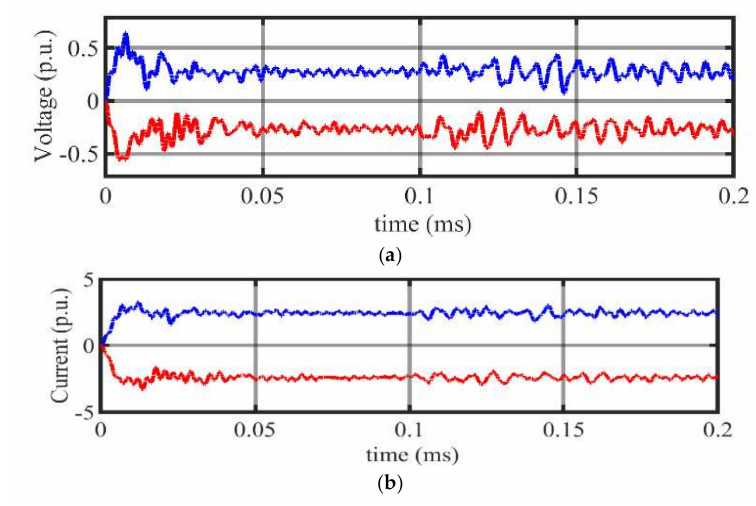
Figure 23. ( a ) DC Voltage and ( b ) DC current profiles under PP fault occurred at 100 km from RS-I on Line 1.